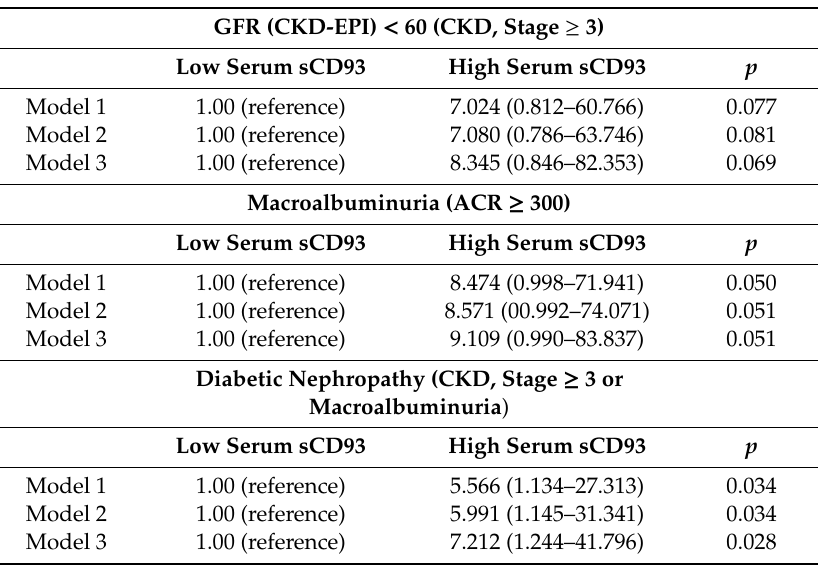
Table 5. Risk of high serum sCD93 levels for renal